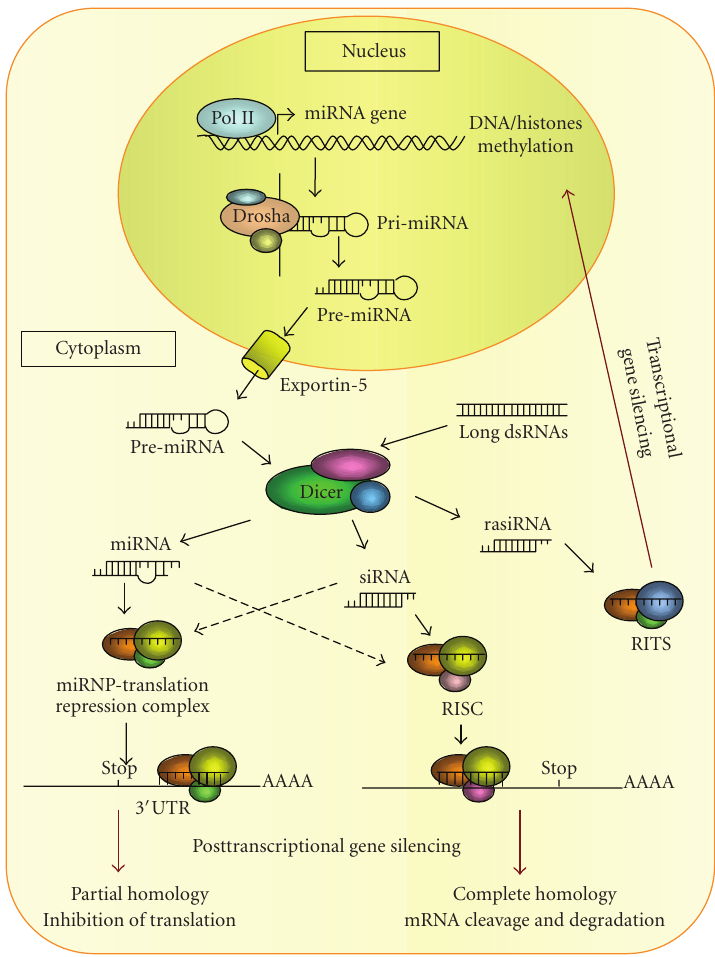
Figure 1: Schematic representation of RNA-mediated gene silencing pathways. miRNAs are transcribed from endogenous genes by RNA polymerase II as long primary transcripts (pri-miRNAs). In the nucleus, Drosha, an RNase III-like enzyme, releases the characteristic stem- loop structure of the ∼ 70 bp precursor-miRNA from the primary transcript (pre-miRNA). The pre-miRNAs are then transported from the nucleus to the cytoplasm by exportin-5, where they are processed by Dicer to generate the mature miRNA of 21–23 nt in length. Similarily, siRNA duplexes of 21–25 nt in length are generated from long dsRNAs in the cytoplasm by Dicer as well. Only the antisense strand of the mature si/miRNAs is retained in the active ribonucleoprotein e ff ector complexes (RISC or miRNP) and acts as a guide to target the homologous mRNA. Normally, siRNAs are fully complementary and induce the cleavage and degradation of their target mRNA transcript. In contrast, miRNAs usually bind only with partial complementarity to the 3 (cid:2) untranslated region (UTR) of their cognate mRNAs and lead to translational inhibition. Depending on the cell context and the degree of complementarity between the small RNA e ff ector and the mRNA target, both siRNA and miRNA can induce posttranscriptional gene silencing through degradation or translational inhibition. In addition, transcriptional gene repression has been described by repeat-associated siRNA (rasiRNA). They are believed to be loaded into RNAi-induced transcriptional gene silencing (RITS) complexes and may target homologous genomic loci. However, this mechanism is not yet fully